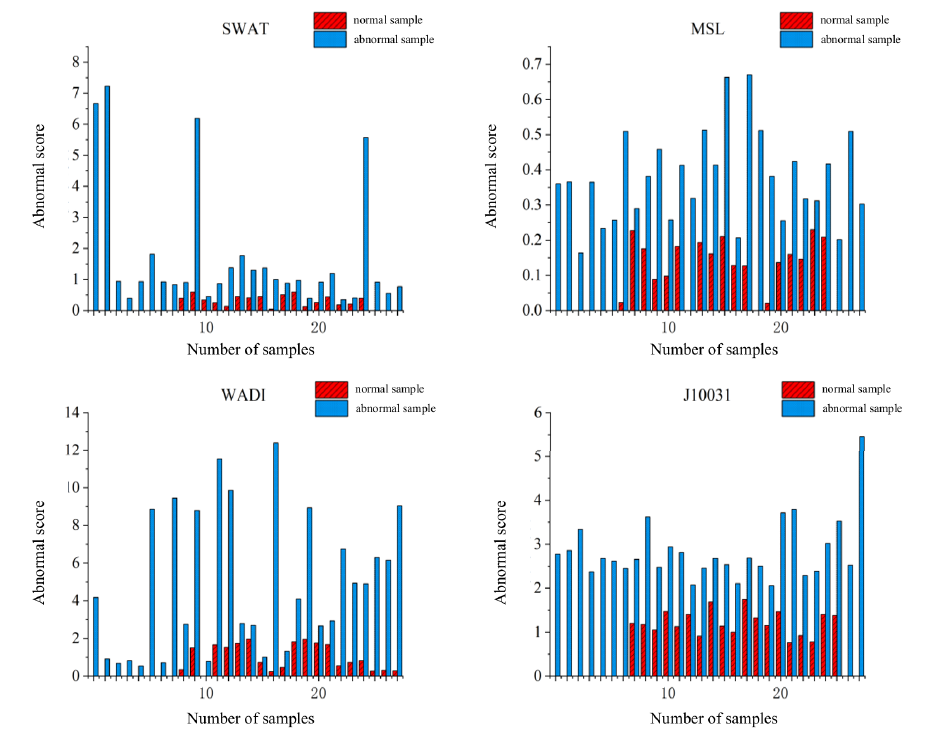
Figure 7. Performance comparison between scoring distribution map.